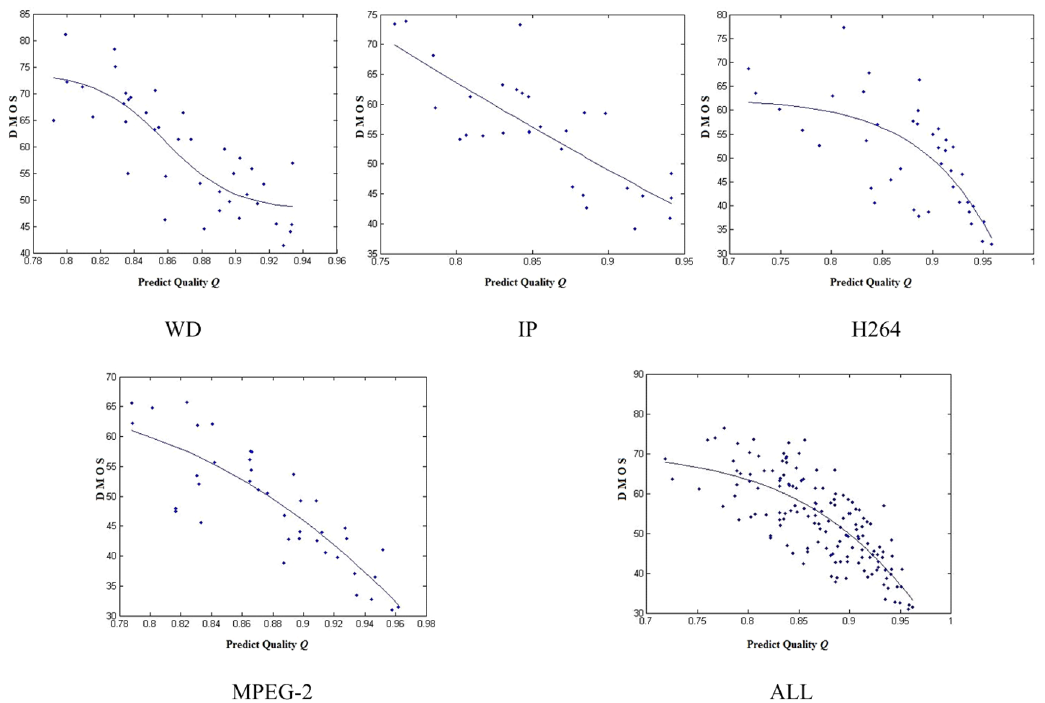
Fig 6. Scatter plots of proposed VQA metric. All distortion types in LIVE video databases are listed.